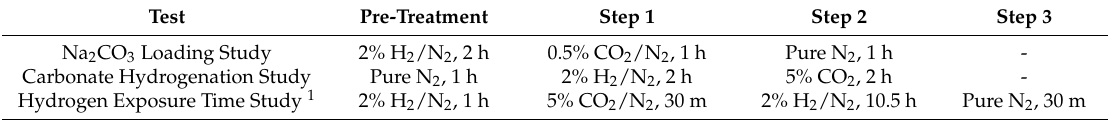
Table 3. Programs of TGA tests at 320 ◦ C related to the results discussed in this paper.